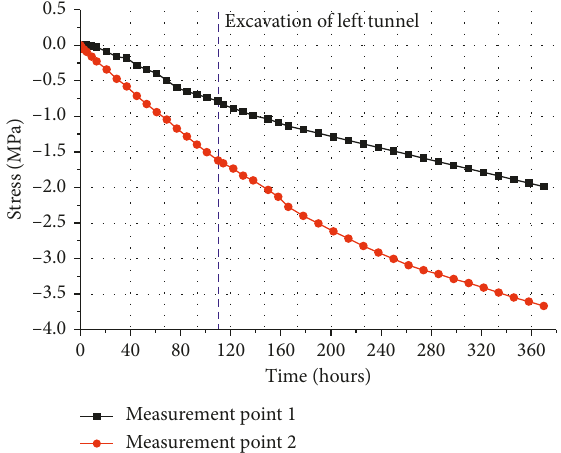
Figure 7: Time history curves of surrounding rock stresses on the right tunnel tube